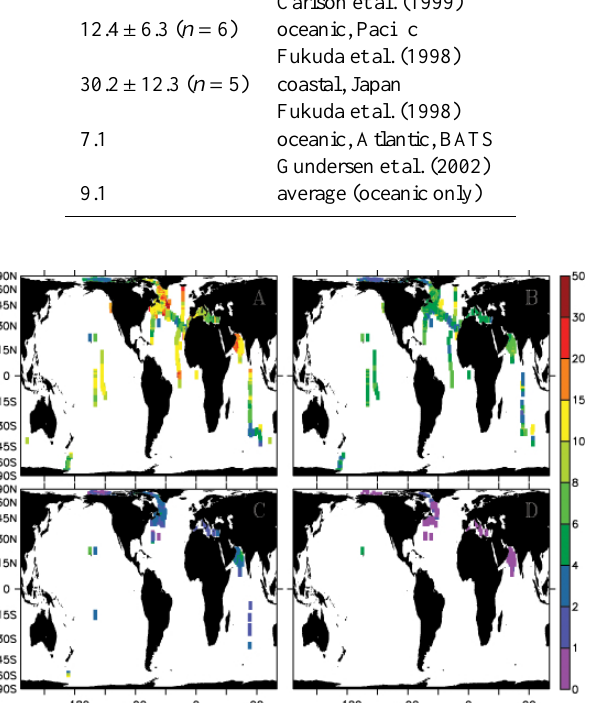
Figure 2. Picoheterotroph biomass ( µ gCl − 1 ) averaged over all available months. (A) 0–40m, (B) 40–225m, (C) 225–950m, (D) ≥ 950m.